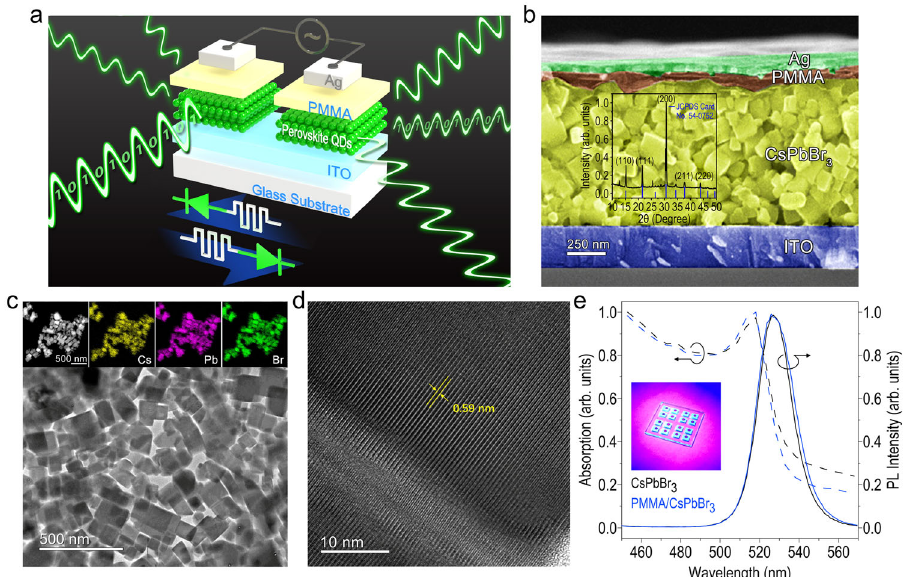
Fig. 1 CsPbBr 3 QD-based LEM device structure and QD properties. a Schematic of the CsPbBr 3 QD-based LEM device composed of two nominally identical devices (top plot), with equivalent electronic circuit symbols illustrating that each device has dual functionalities either as RRAM or LEC, depending on the electric fi eld direction across the LEM (bottom plot). b Cross-sectional scanning electron microscope (SEM) image of the as-fabricated LEM, where the scale bar is 250nm. XRD pattern of the CsPbBr 3 QDs along with that of the cubic structure (JSPDS No. 54-0752) is inserted in the fi gure. c TEM image of the CsPbBr 3 QDs. Insets show the EDS mapping of the CsPbBr 3 QDs for analyzing the elements of Cs, Pb, and Br. d High resolution TEM of the CsPbBr 3 QDs to identify the interplanar space of (200) plane. A clear fused interface is also observed in this fi gure. e Absorption (primary vertical axis) and PL spectra (secondary vertical axis) of the CsPbBr 3 QD fi lms with and without the PMMA protection layer. Inset: A photograph of the as-fabricated LEM taken under the illumination of 405 nm